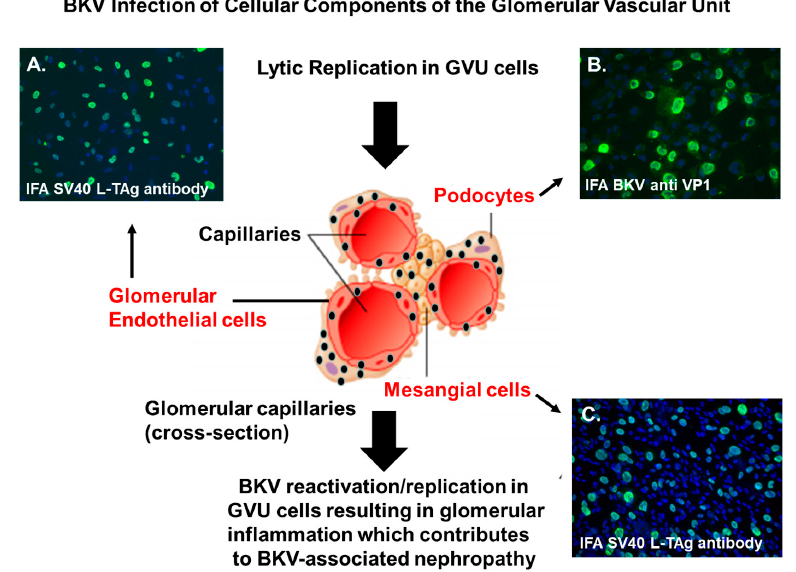
Figure 1. BK polyomavirus (BKV) infection of GVU cells. Immunofluorescent staining of GVU cells infected with BKV. ( A ) Primary human glomerular endothelial cells infected with BKV for 96 h and stained with a monoclonal antibodies against the SV40 Large T antigen (LTAg). ( B ) Human podocytes infected with BKV for 96 h and stained with monoclonal antibodies against the BKV major capsid protein VP1. ( C ) Primary human mesangial cells infected by BKV for 96 h and stained with a monoclonal antibody targeting the SV40 (LTAg). Nuclei were stained blue with 4 ′ ,6-diamidino-2-phenylindole (DAPI). All images were obtained using a Nikon TE2000S microscope mounted with a charge-coupled device (CCD) camera at ×200 magnification.